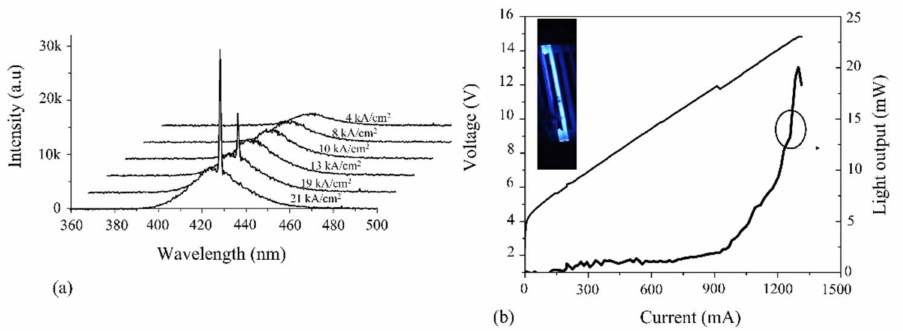
Figure 5. ( a ) Lasing spectrum of an RIE facet ELO wing LD with increasing injection current density (4–21 kAcm − 2 ). ( b ) L-I-V curve of an ELO wing LD with an RIE-formed facet. Inset: Optical microscope image of an illuminated laser